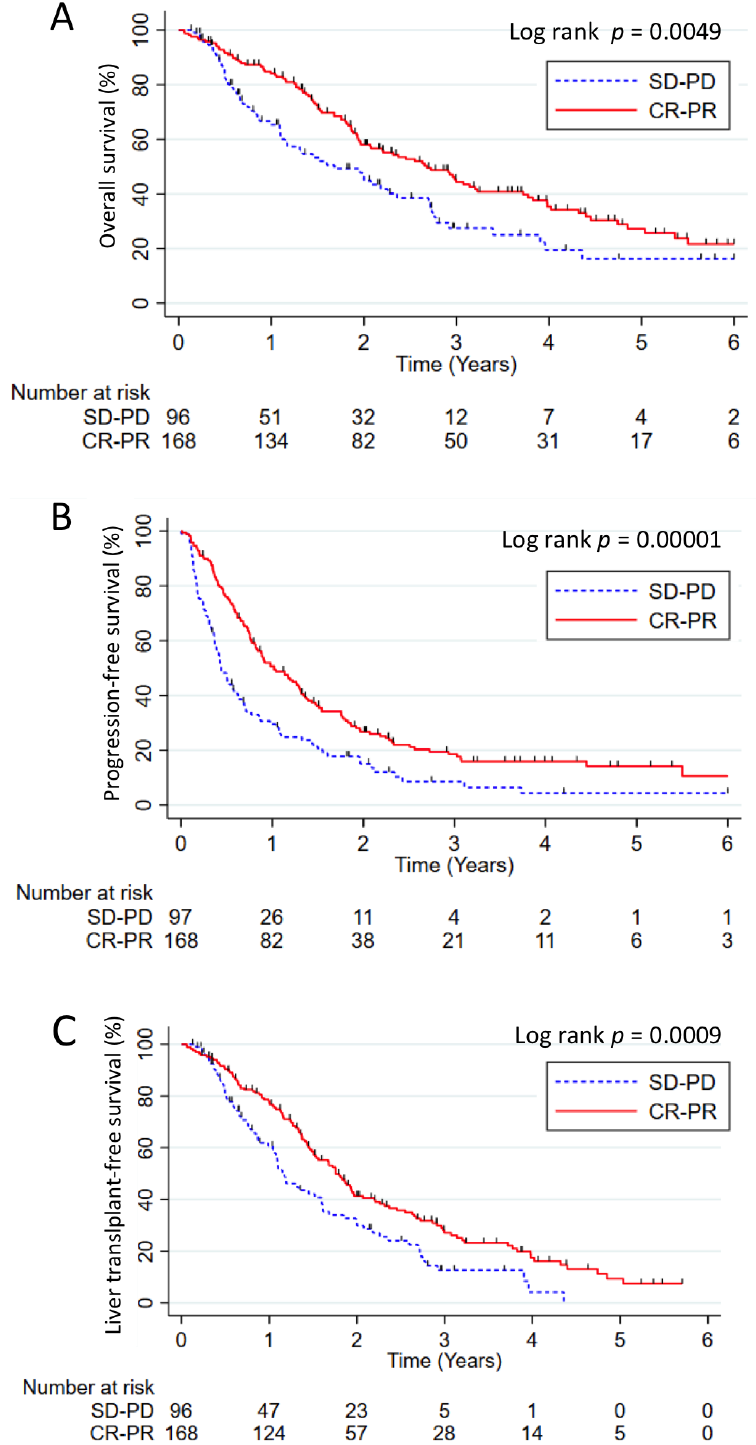
Figure 1. Outcomes according to radiological response. Overall survival ( A ), progression-free sur- vival ( B ) and liver transplantation-free survival ( C ) in patients with radiological response (complete and partial response) versus patients with stable disease or progressive disease according to modified Response Evaluation Criteria in Solid Tumors (mRECIST) criteria. The results were analyzed using the Kaplan – Meier method and compared using the log rank test. Numbers at risk were reported under the x -axis.